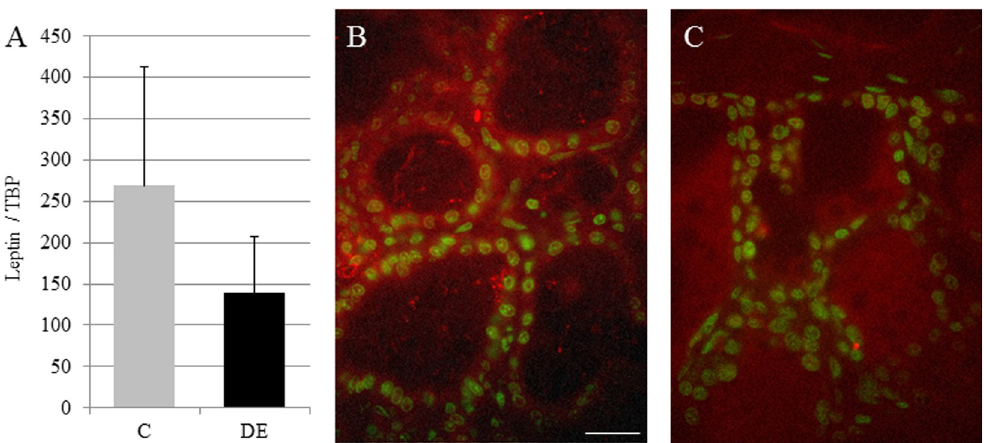
Fig 3. Leptin expression and localisation in mammary glands from C and DE rabbits at day 28 of pregnancy. (A) Expression of leptin in mammary glands at day 28 of pregnancy from control (in light grey) and exposed (DE) (in black) dams. Real-time RT-PCR was quantified using TBP housekeeping gene. Data are mean ± SEM. (B and C) Representative images of leptin immunostaining (red) of mammary gland from control (B) or exposed (C) dams at day 28 of pregnancy. Nuclei are stained in green. Scale bar represents 50 μ